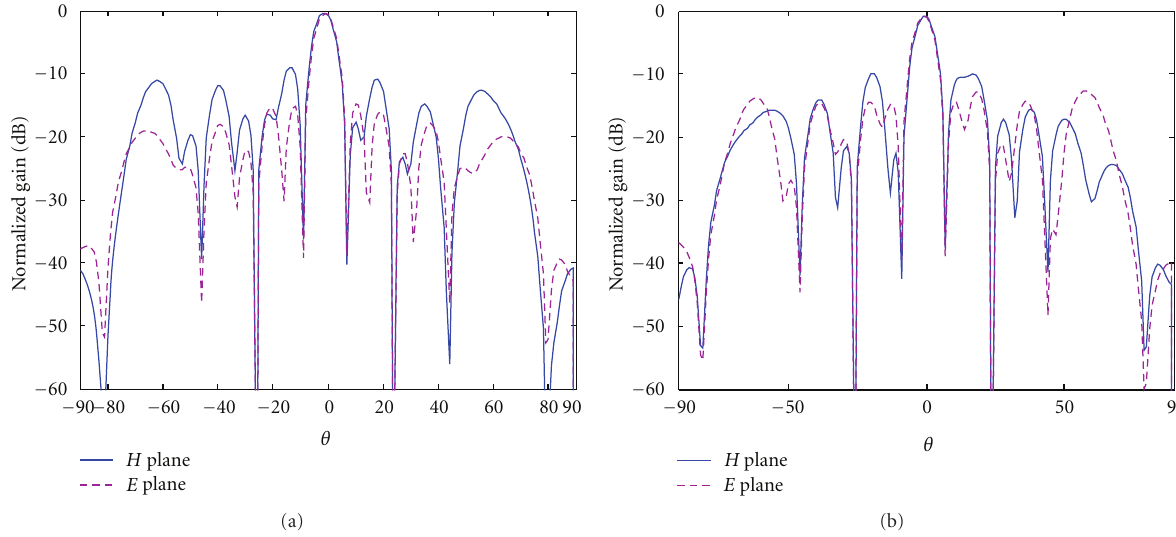
Figure 7: Measured antenna far-field radiation pattern at 5.5GHz: (a) vertical and (b)